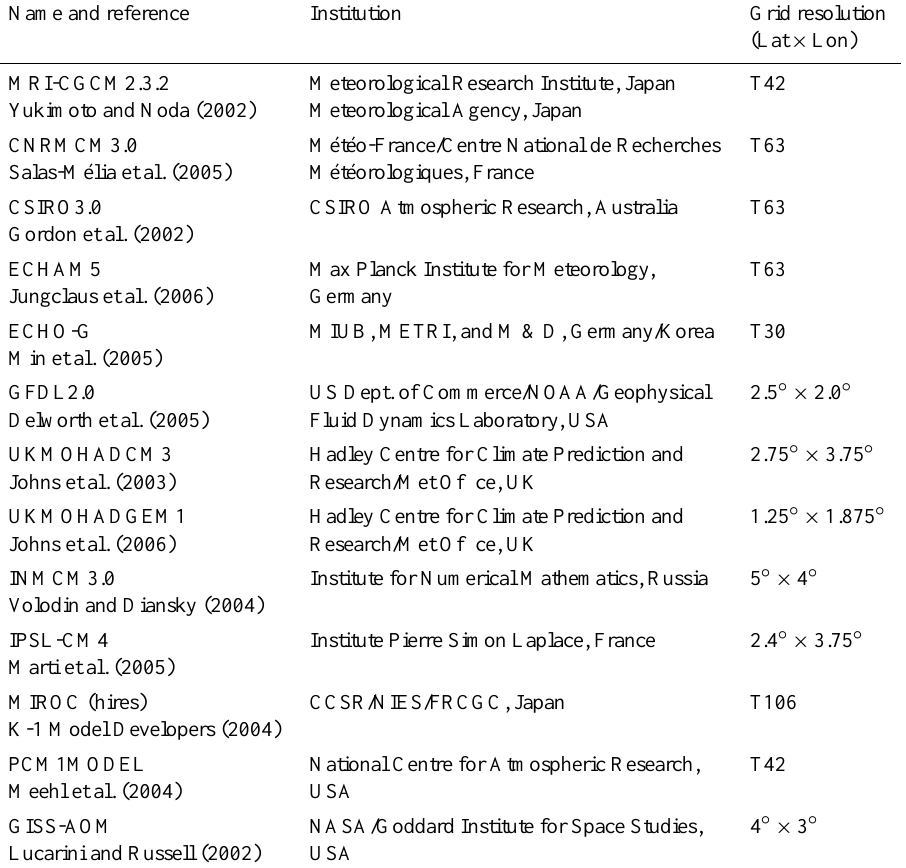
Table 2. List of GCMs used in the study. These constitute the subset of all GCMs included in the PCMID/CMIP3 project providing all the climate variables of our